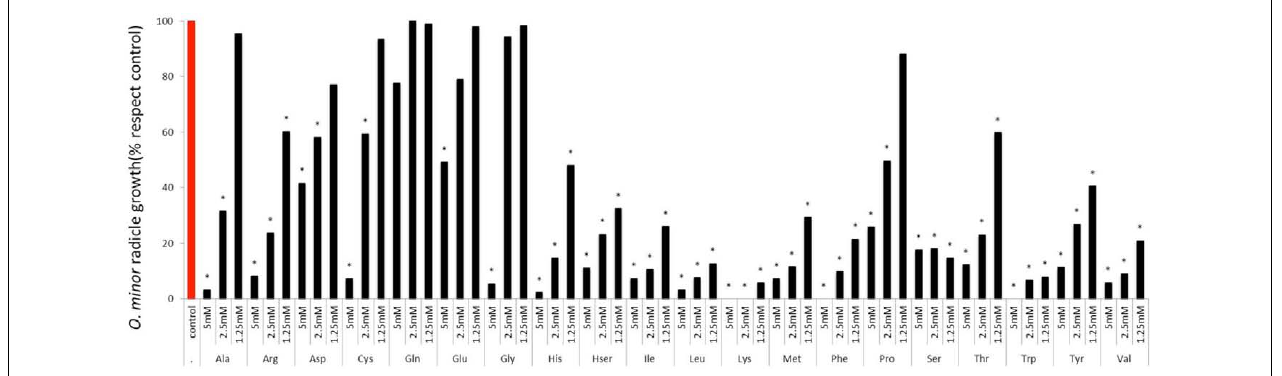
FIGURE 3 | Influence of amino acid treatments on O. minor radicle growth in vitro . Treatment solutions of alanine, arginine, aspartate, cysteine, glutamic acid, glutamine, glycine, histidine, homoserine, isoleucine, leucine, lysine, methionine, phenylalanine, proline, serine, threonine, tryptophan, tyrosine, and valine along with a germination stimulant GR24 were applied to O. minor seeds at a range of 5–1.25 mM and their activity in growth reduction rated 7 days later in each of three replicated disks and expressed as a percent of the untreated control activity. Analysis of variance was applied to transformed replicate data. ∗ Indicates differences of each treatment compared with the control assessed by Dunnett’s test at the 0.05 level.